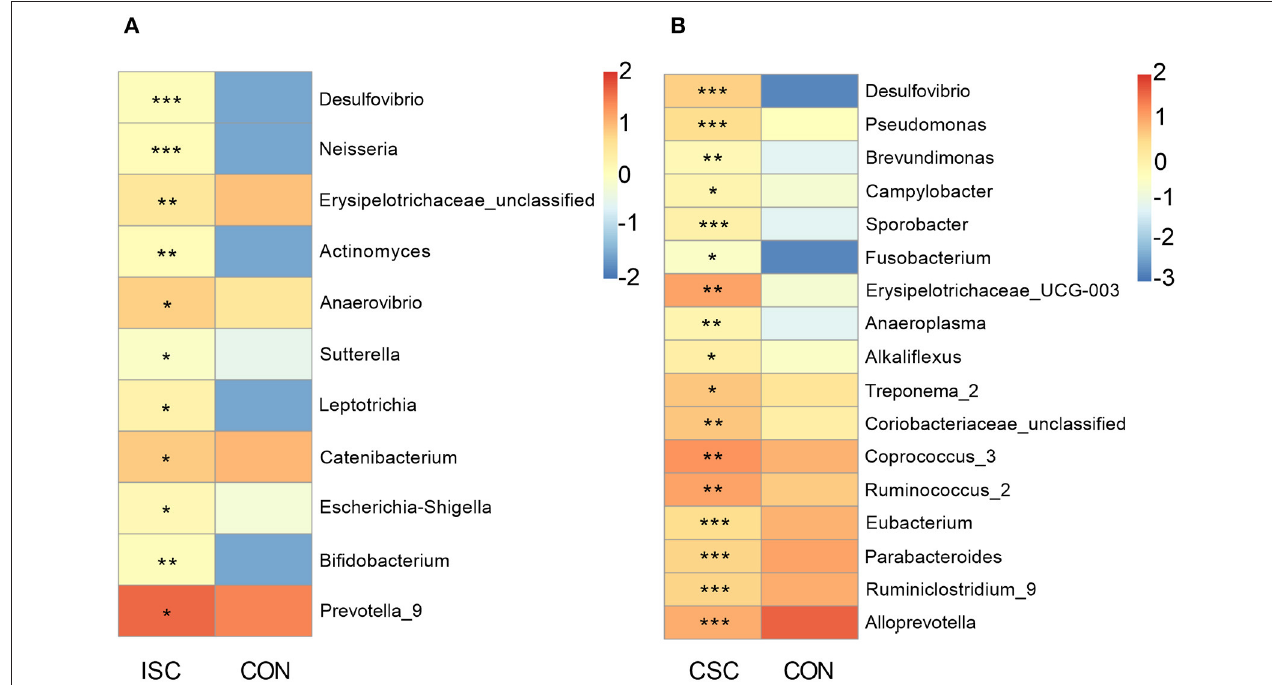
FIGURE 3 | The abundance of differential genera in feces of piglets. (A) The differential genera between the ISC and CON groups. (B) The differential genera between the CSC and CON groups. The differential genera were analyzed by Wilcox test. All values are expressed as the means ± SEM. * p < 0.05, ** p < 0.01, *** p < 0.001. ISC, intermittent social contact; CSC, continuous social contact; CON,